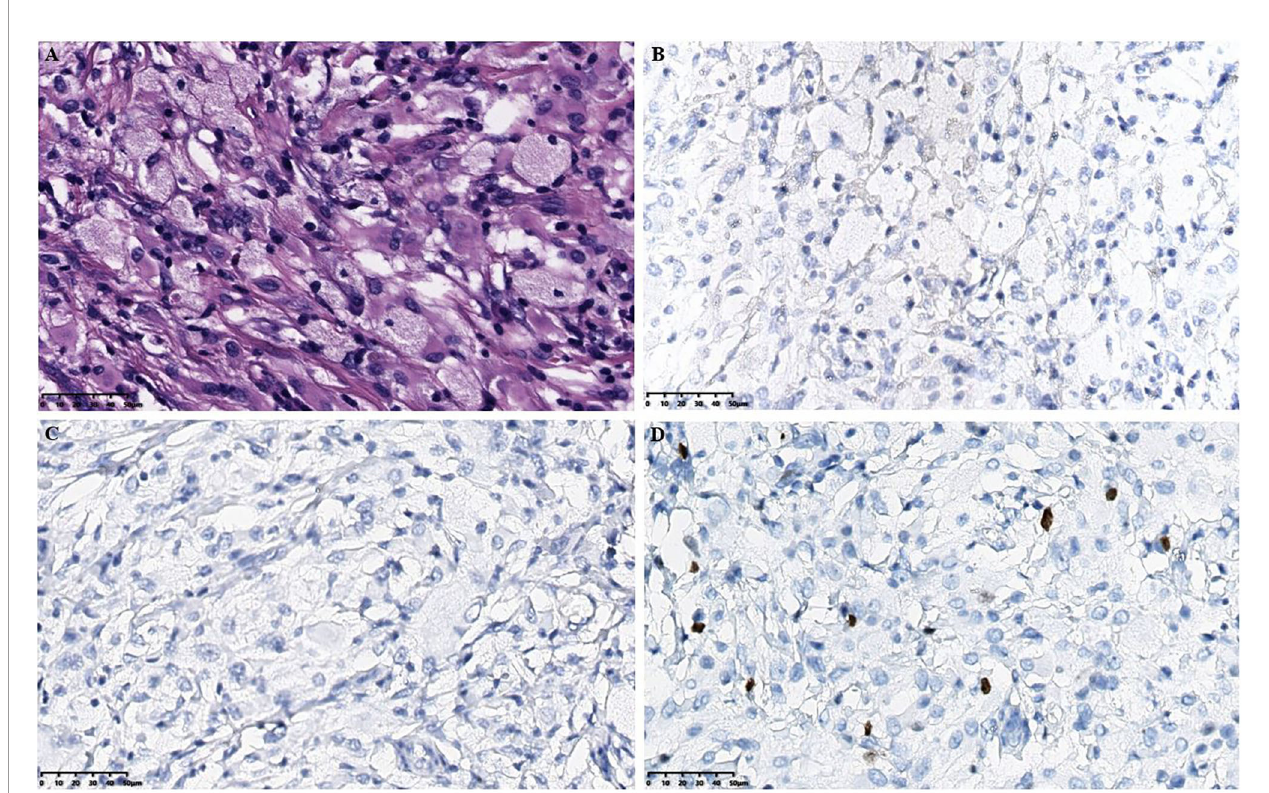
FIGURE 2 | Histopathological results in the intracranial lesion tissue. (A) Hematoxylin-eosin staining in the intracranial lesion tissue showed abundant cytoplasm in the ventricular soft tissue mass cells with foamy or eosinophilic histiocytic in fi ltration (scale bar is 50 m m). (B) Immunohistochemical CD1a staining showed negative tissue cells (scale bar is 50 m m). (C) Immunohistochemical langerin staining showed negative tissue cells (scale bar is 50 m m). (D) Immunohistochemical Ki-67 staining showed a small amount of positive tissue cells (scale bar is 50 m